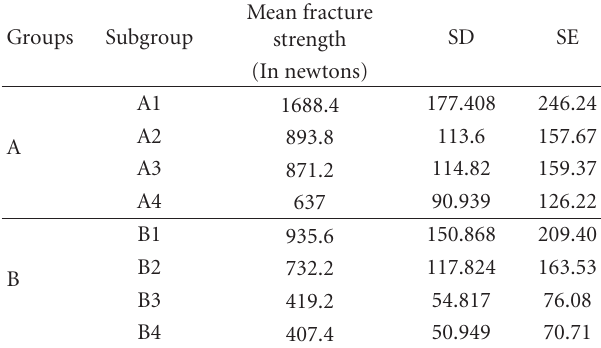
Table 1: Table showing the fracture strength of the various samples in newtons with standard deviation (SD) and standard error (SE) in